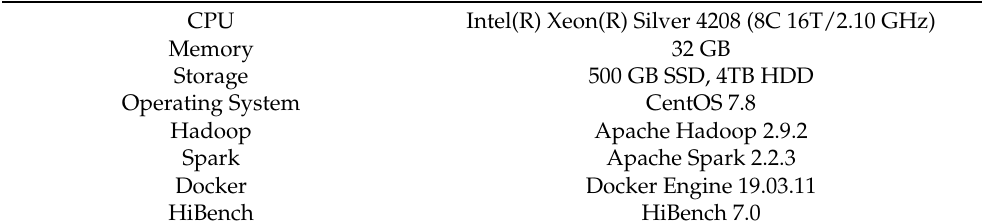
Table 3. Testbed H/W and S/W